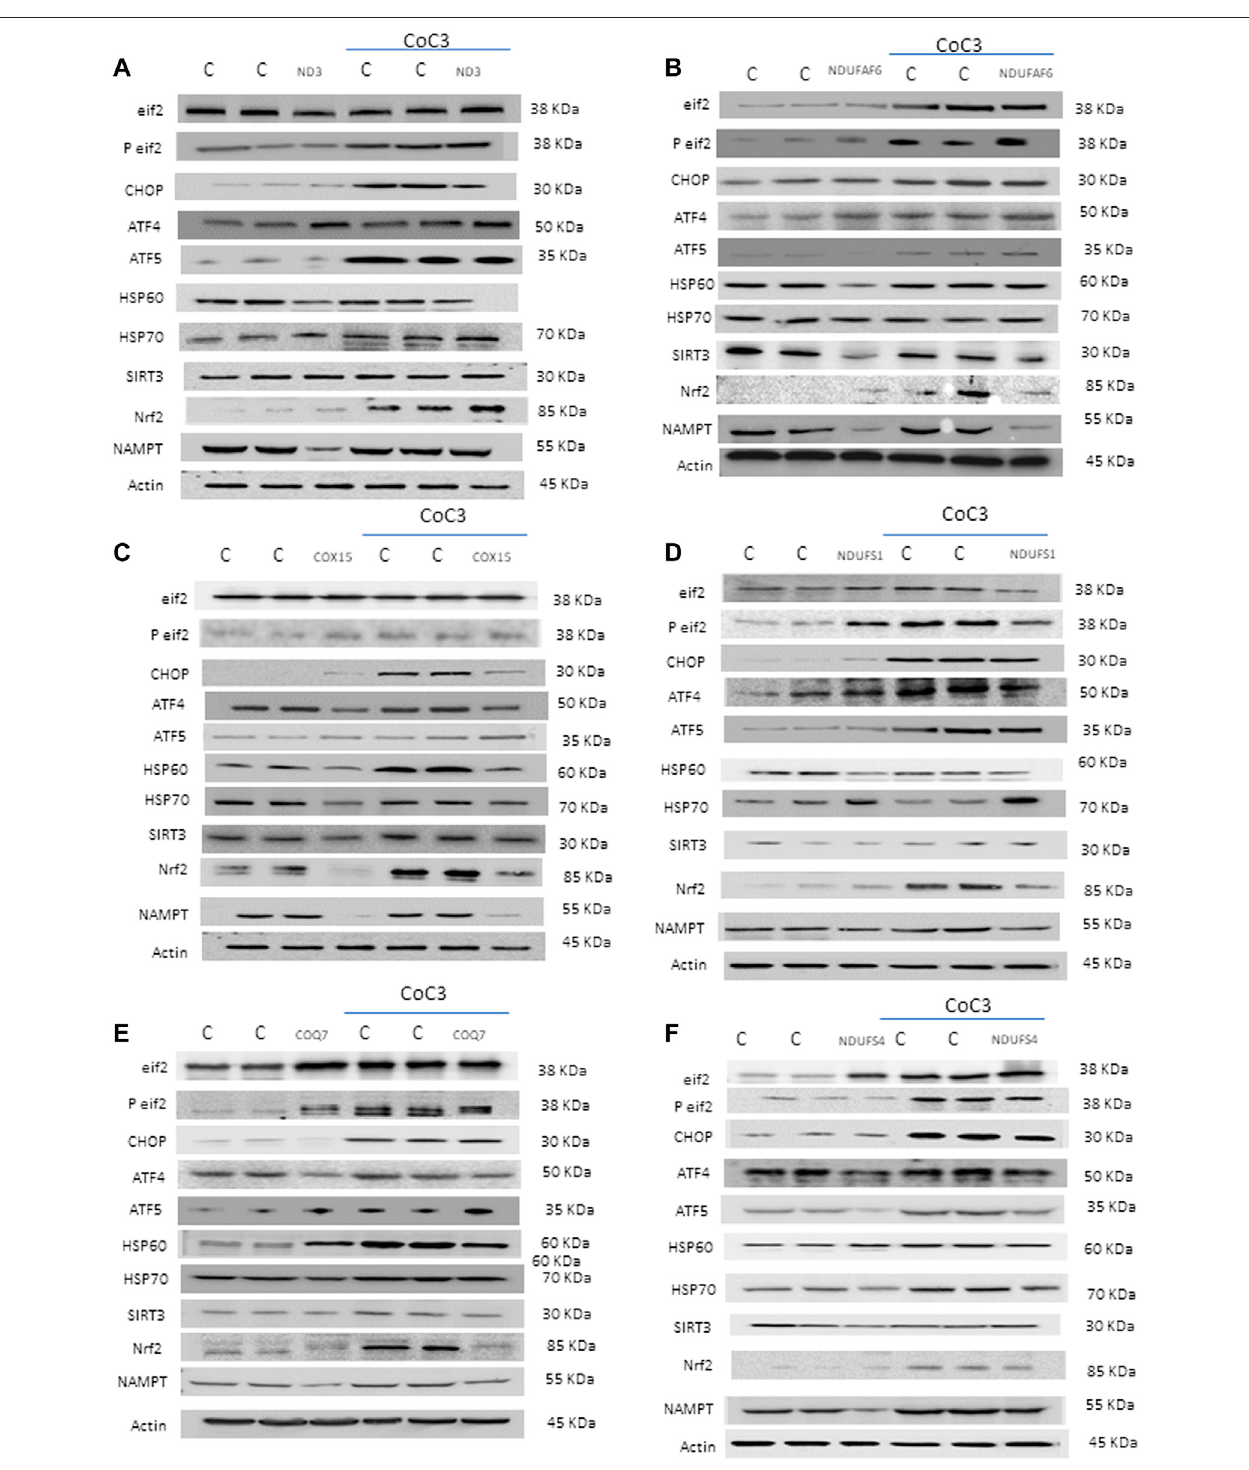
FIGURE6| EffectofCoC3ontheexpressionlevelsofUPR mt -relatedproteinsincontrolandmitochondrialmutantcelllines.WesternblotanalysisofseveralUPR mt -related proteins: Eif2 α and P-eif2 α proteins as Integrated Stress Response (ISR) markers; ATF4, ATF5 and CHOP proteins as canonical UPR mt proteins; HSP60 and mtHSP70proteinsaschaperones;SIRT3protein asmaintargetofpterostilbene;Nrf2protein asamodulatorofmitochondrialantioxidantpathways;NAMPTenzymeas NAD + /NADH cell metabolism regulator. “ C ” stands for healthy control cells. Fibroblasts were treated for 7 days with CoC3 treatment: 1 μ M Pterostilbene, 5 μ M nicotinamide, 1 μ M ribo fl avin, 1 μ M thiamine, 1 μ M biotin, 5 μ M lipoic acid and 1 μ M L -carnitine. Mutations in fi gure panels: mtND3 (A) , NDUFAF6 (B) , COX15 (C) , NDUFS1 (D) , COQ7 (E) , NDUFS4 (F) . A representative actin band is shown for all assays, although loading control was checked for every Western blot. Band densitometry is shown in Supplementary Figure S7 .